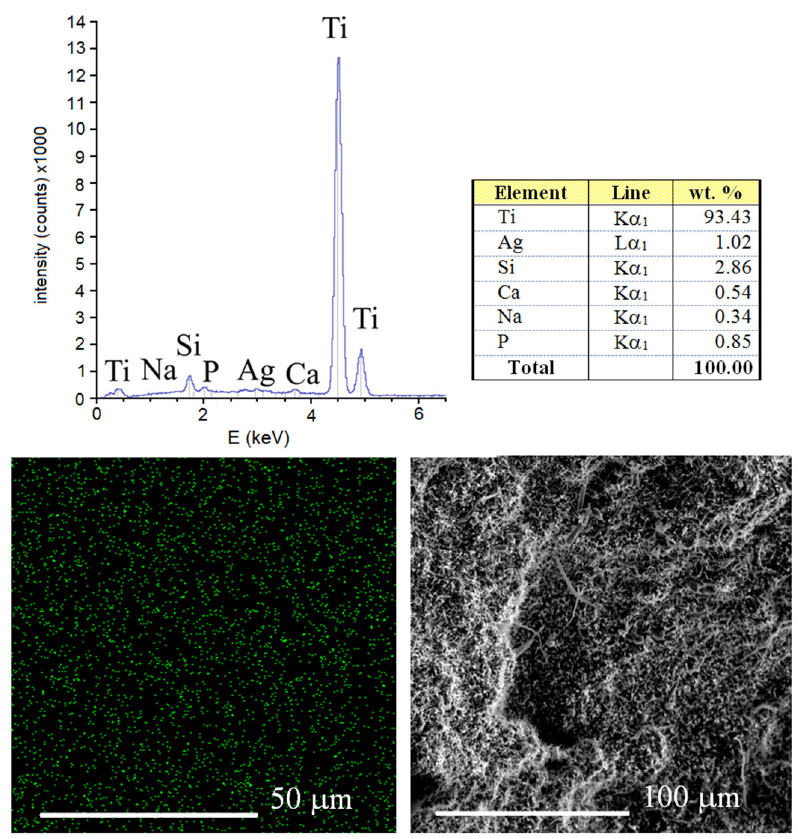
Figure 5. EDS surface spectrum and chemical composition analysis of the Ti-10 wt% 45S5 Bioglass-1 wt% Ag foam with distribution of Ag